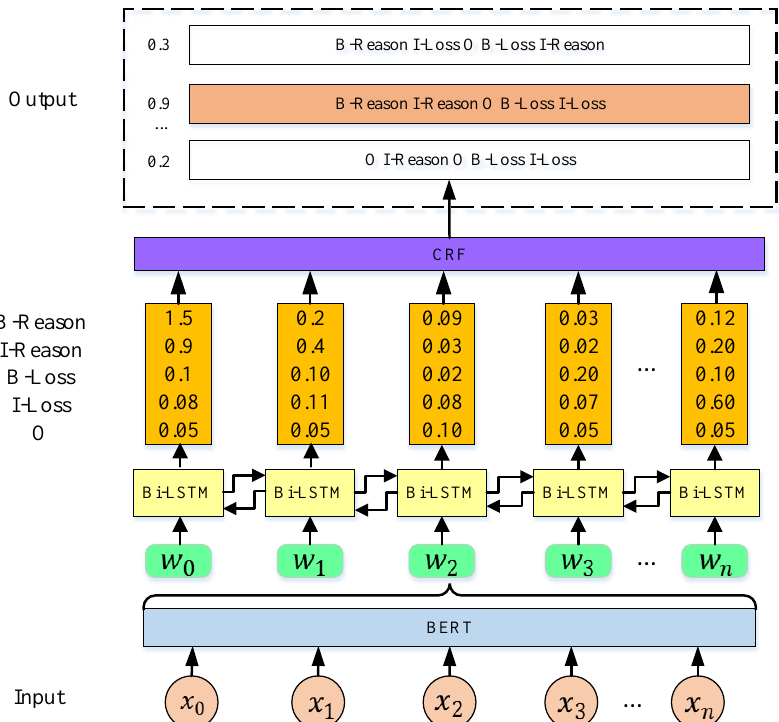
Figure 4. NER model based on BERT-Bi-LSTM-CRF.